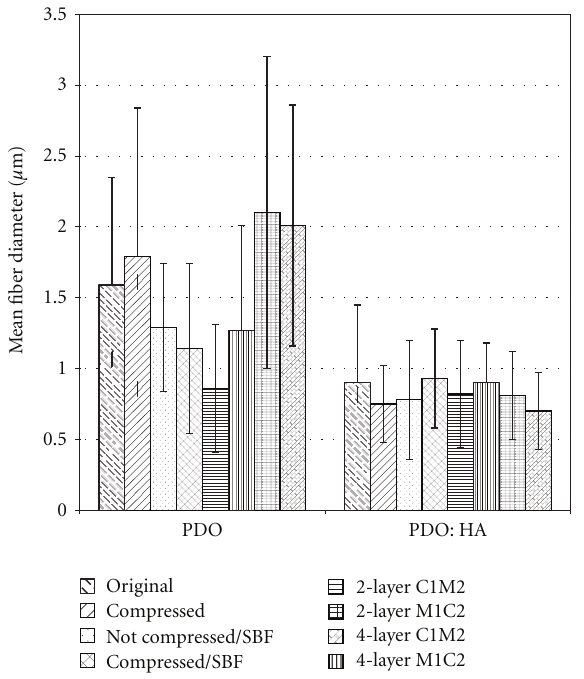
F 2: Fiber diameters of original, mineralized, and multilayered scaffolds.